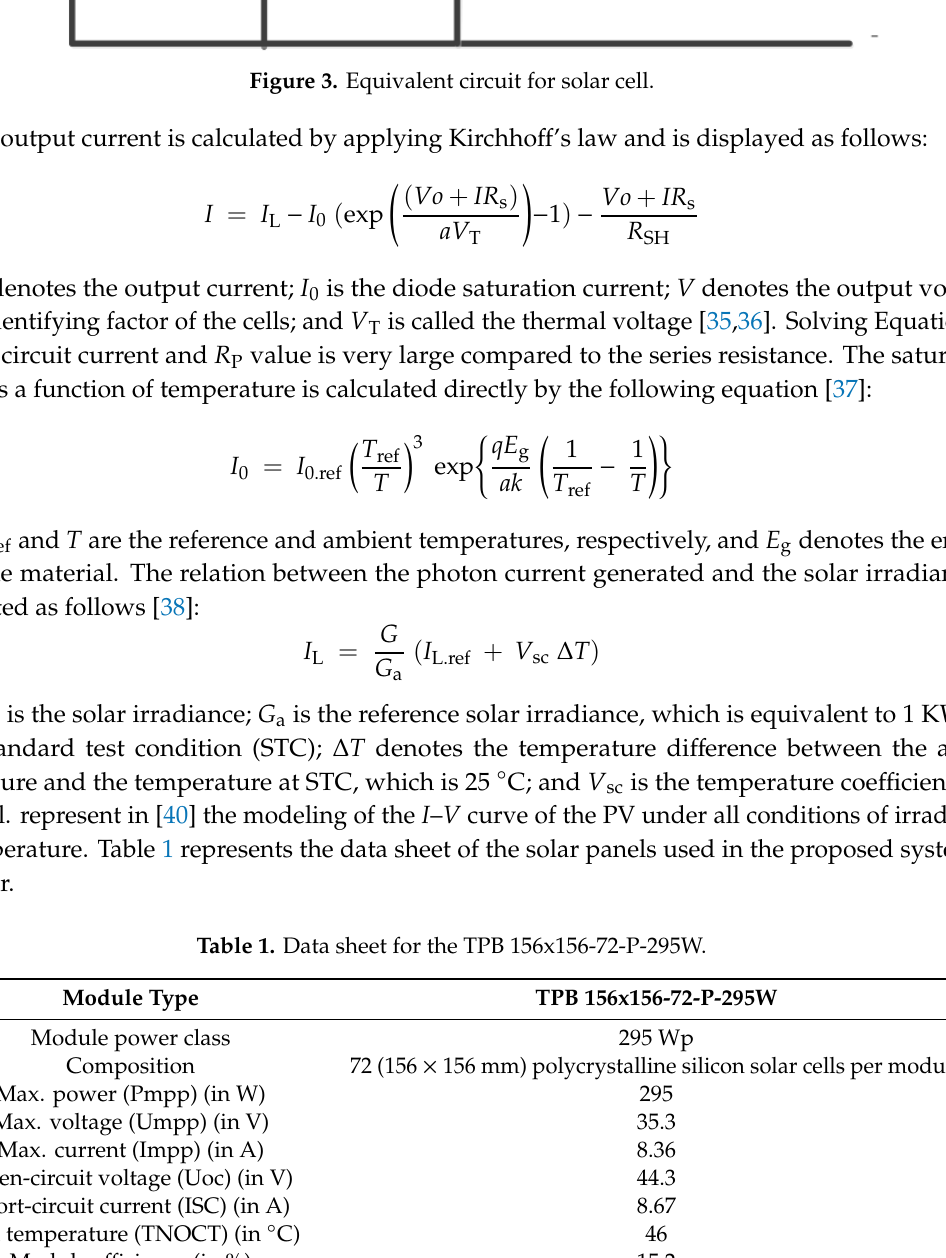
Table 1. Data sheet for the TPB 156x156-72-P-295W.